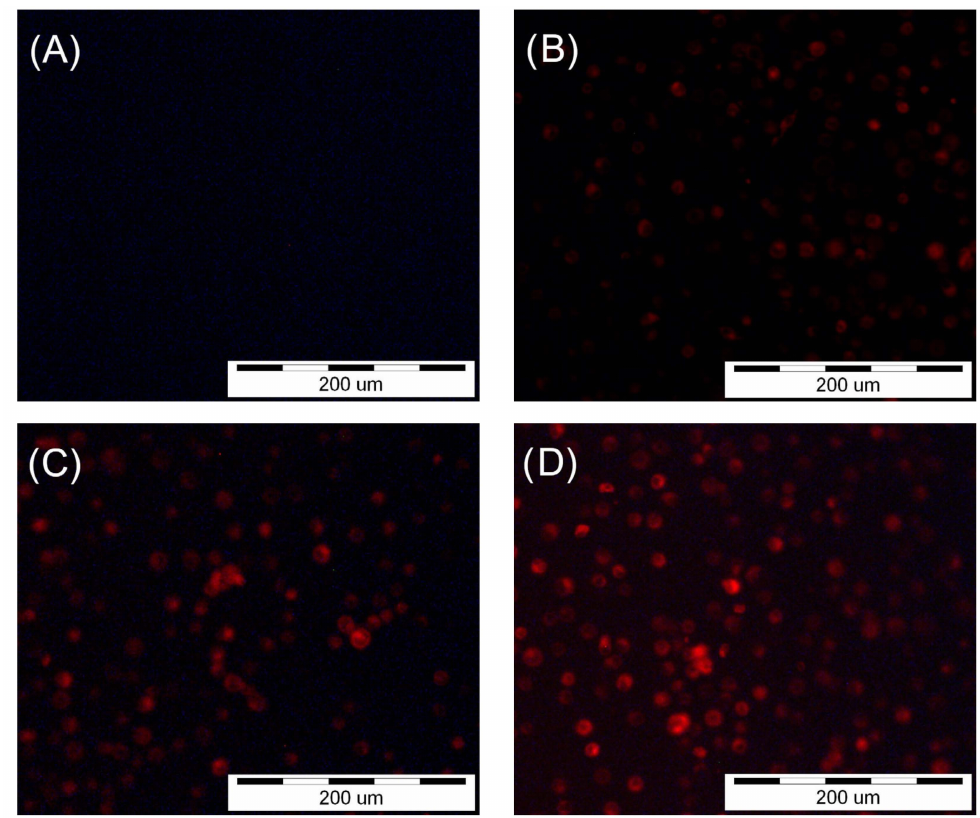
Figure 2. Images of the HGF-1 cells were obtained using an inverted fluorescence microscope after two-hour incubation with HY. ( A ) No fluorescence after incubation with 0 µ M HY solution. ( B ) Fluorescence after incubation with 0.25 µ M HY solution. ( C ) Fluorescence after incubation with 0.5 µ M HY solution. ( D ) Fluorescence after incubation with 1 µ M HY